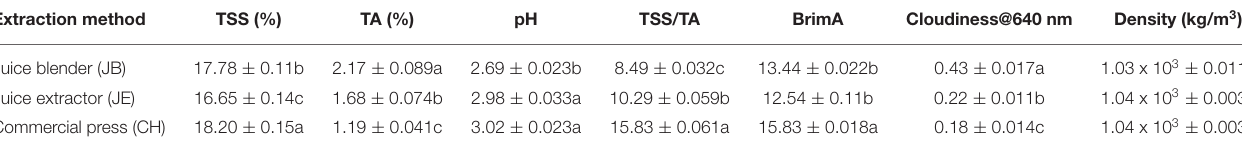
TABLE 3 | Physicochemical properties of pomegranate juice (cv. Wonderful) extracted by using three different methods. Extraction